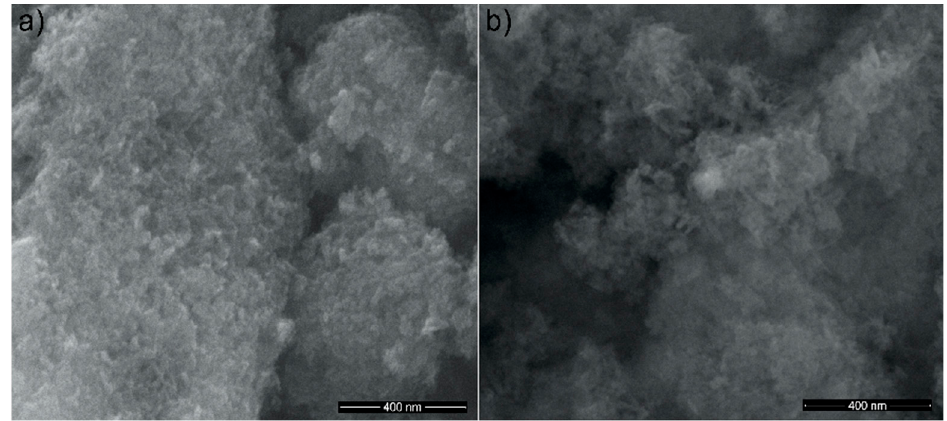
Figure 3. SEM images of HAp ( a ); and hydroxyapatite recovered after zinc adsorption from aqueous solutions (HApD) containing concentration of 50 mg/L zinc ions ( b ).